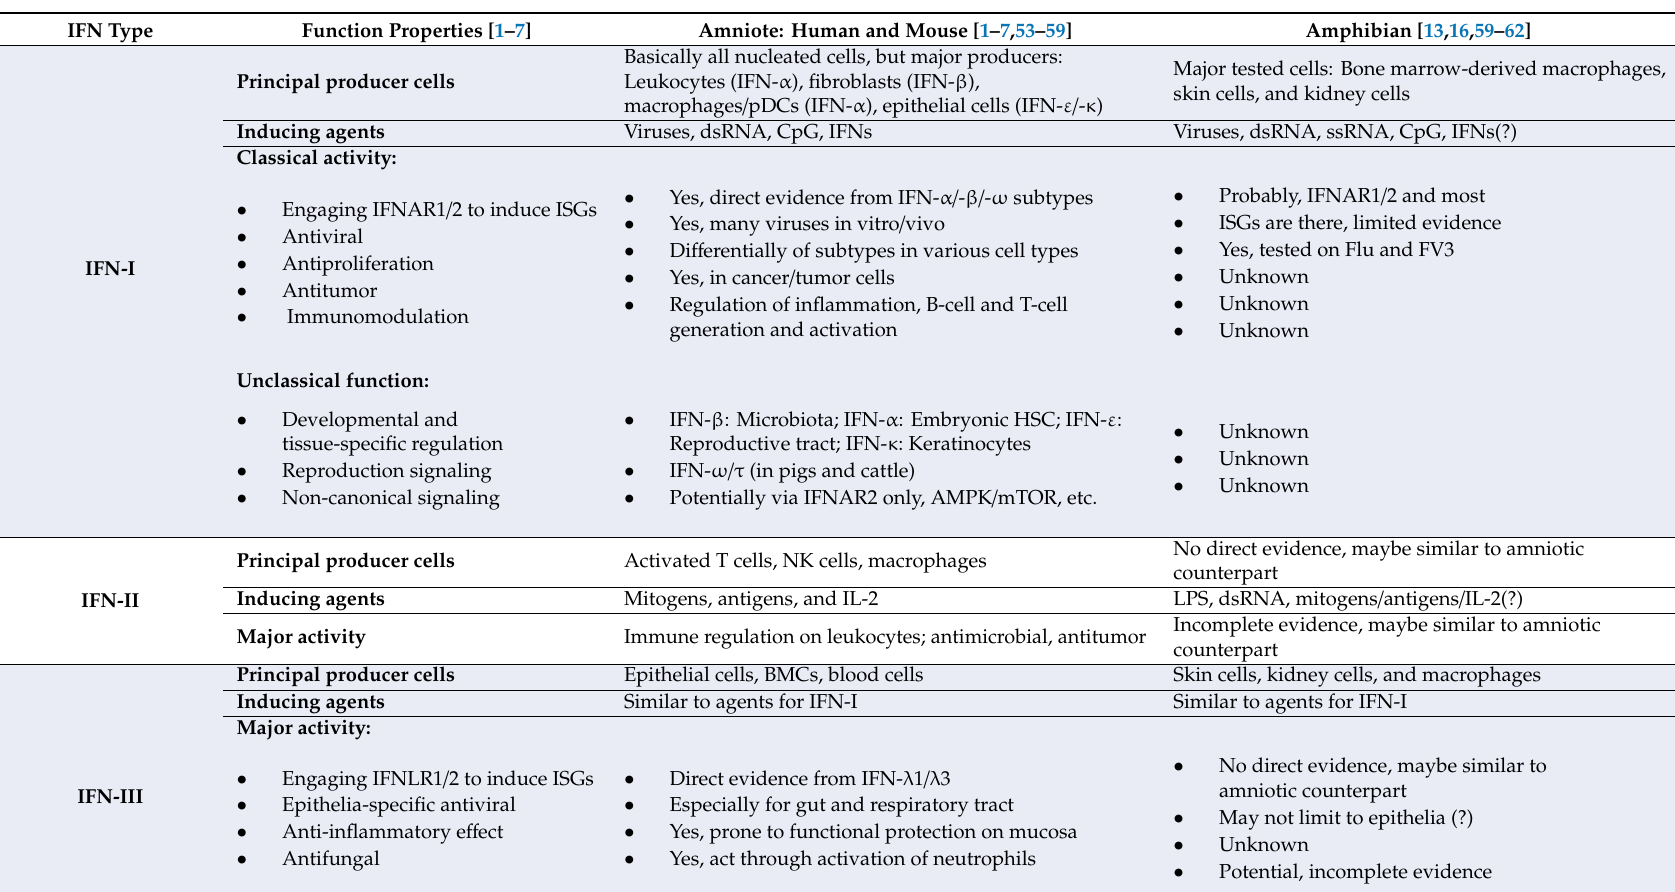
Table 2. Functional knowns and unknowns about amphibian IFN complex referring to well-studied amniotic